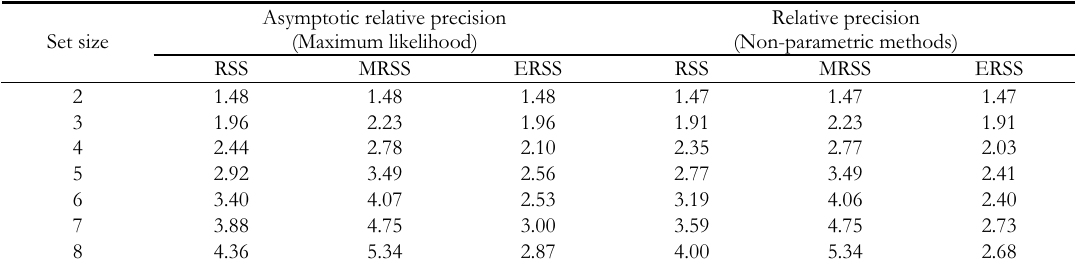
Relative precision (Non-parametric methods) Set size